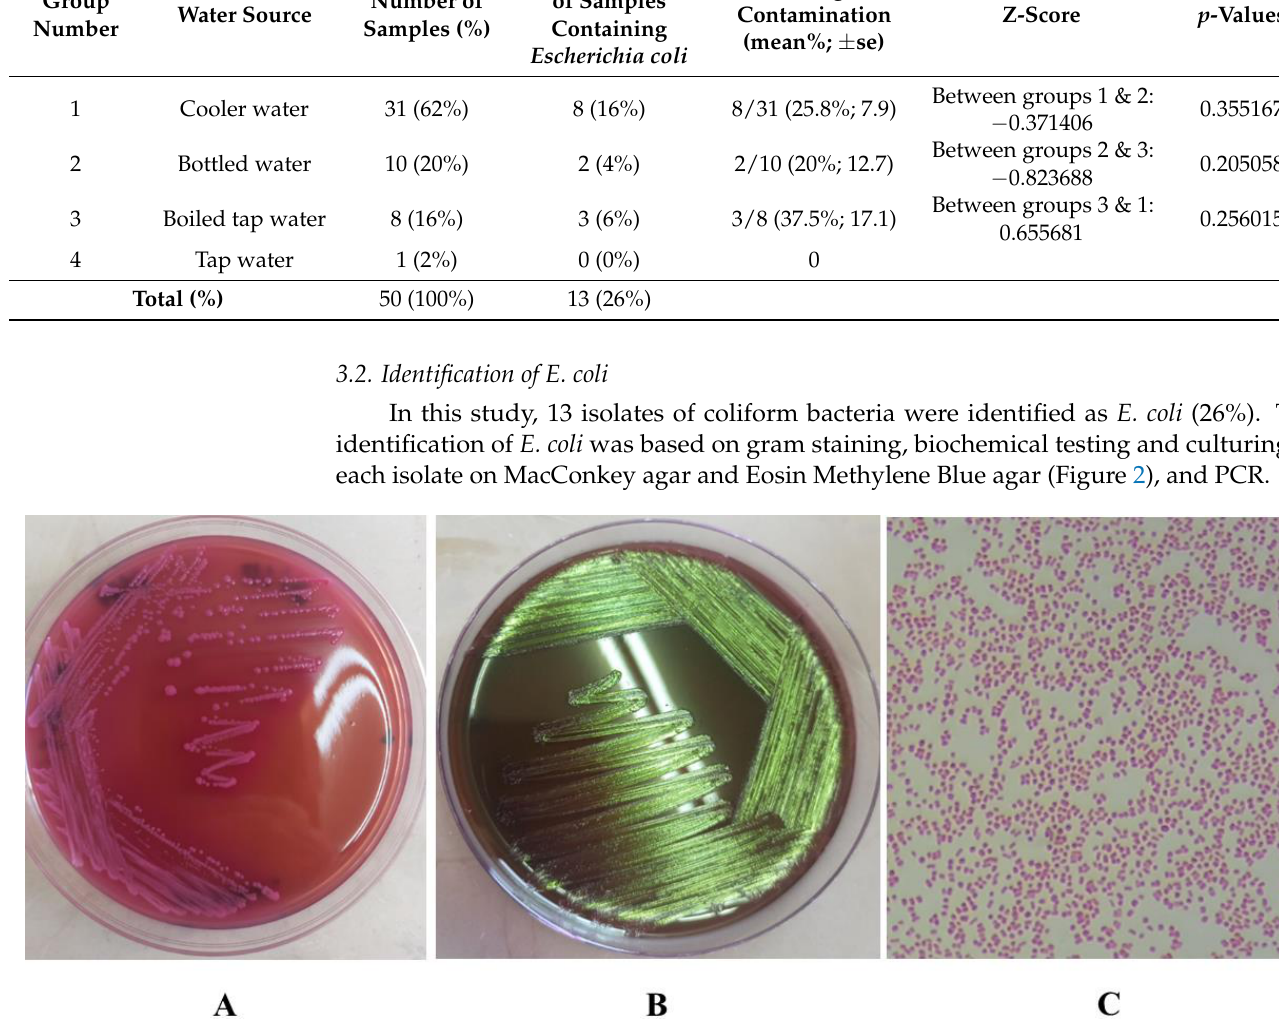
Figure 2. ( A ). The growth of Escherichia coli on MacConkey agar show colonies that are dry, donut shaped and dark pink in colour, surrounded with dark pink area of precipitated bile salts. ( B ). Growth of E. coli on EMB agar shows the characteristic green metallic sheen. ( C ). Morphology of E. coli cells by microscopy after gram staining, showing gram negative, short rods.